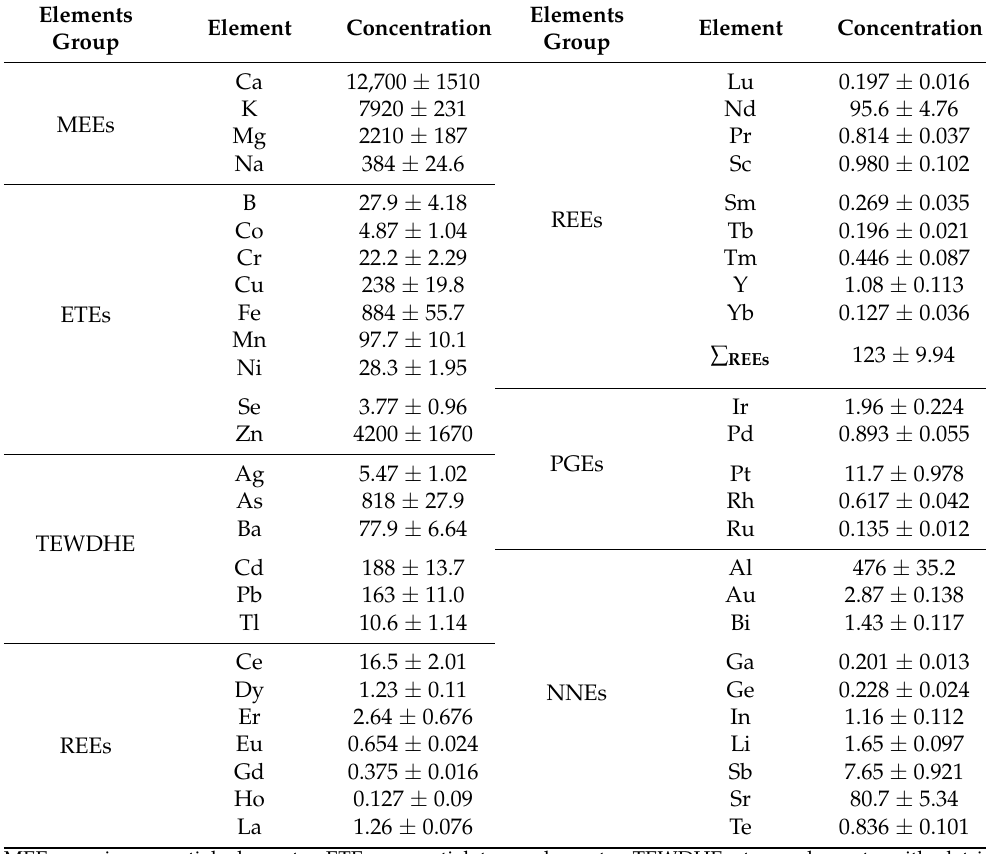
Table 1. Concentration of elements [mg kg − 1 dry weight] in flotation tailings used in experiment.